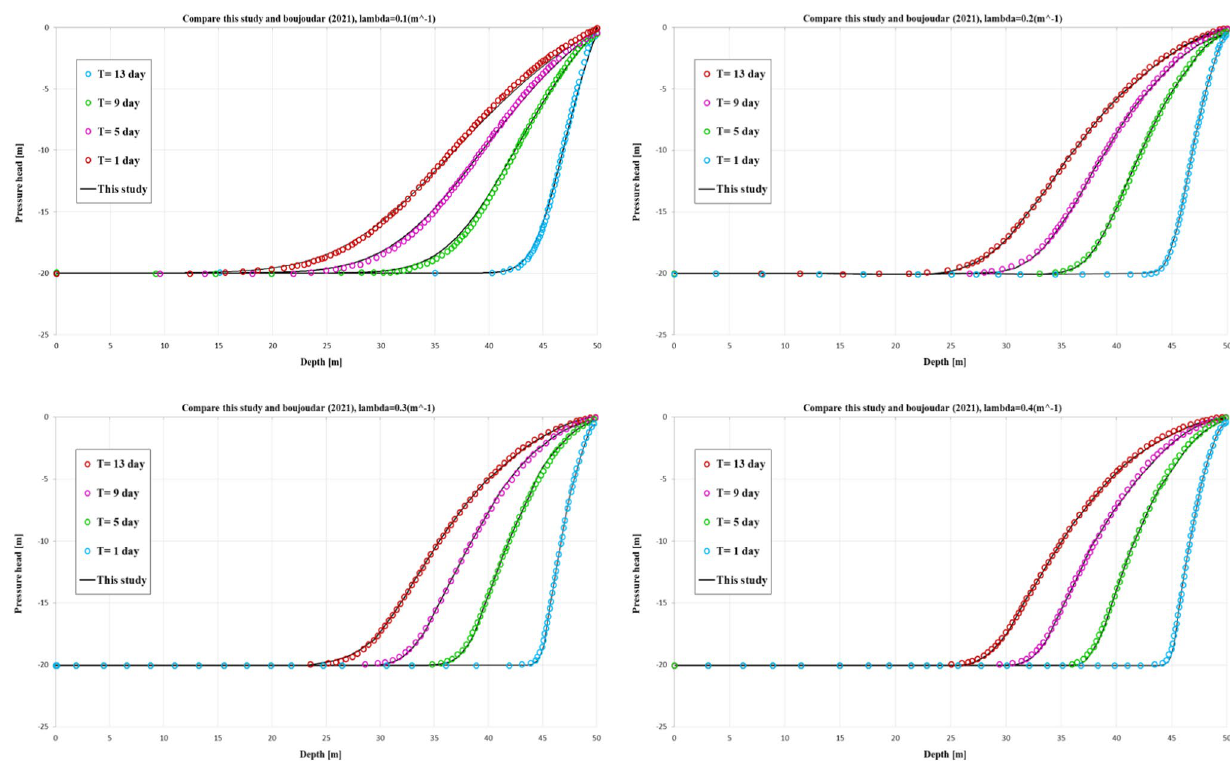
Fig. 6 Comparison of the time evolution of the suction modeled by meshless Petrov–Galerkin method and the numerical solution of the Rich- ards equation (Boujoudar et al 2021a,